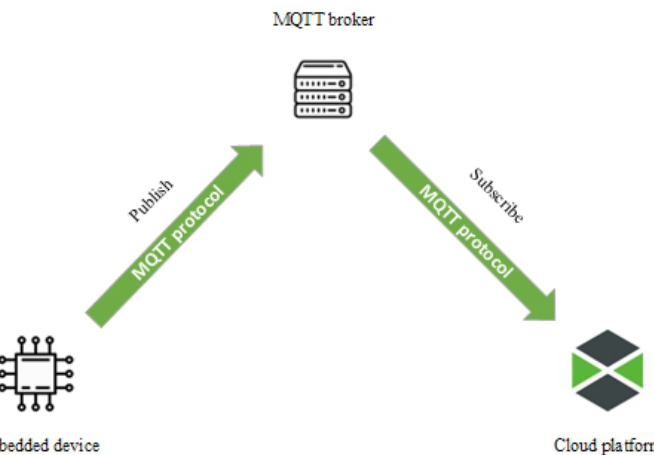
Figure 8. MQTT protocol uses publish/subscribe method to send